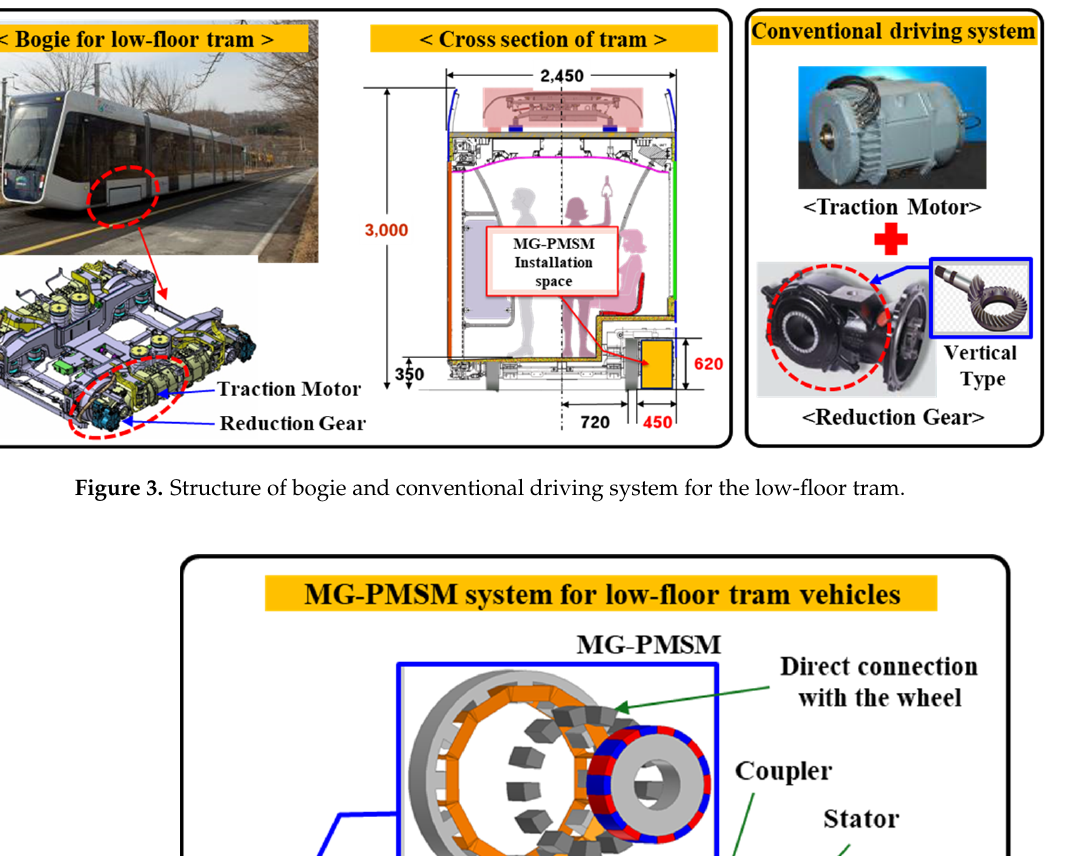
Figure 4. Application concept of MG ‐ PMSM to low ‐ floor tram driving system.